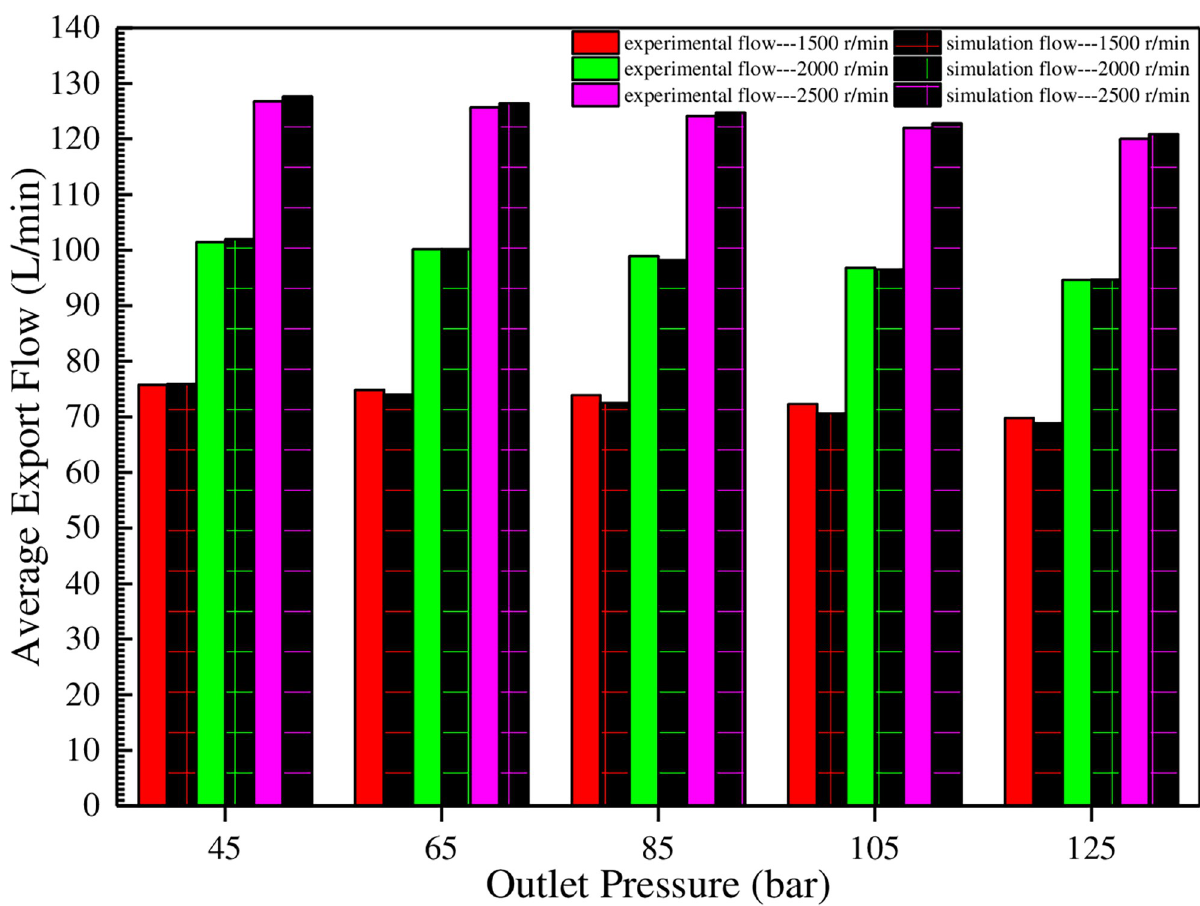
Fig 21. Comparison of experimental and simulated average export flows under variable working